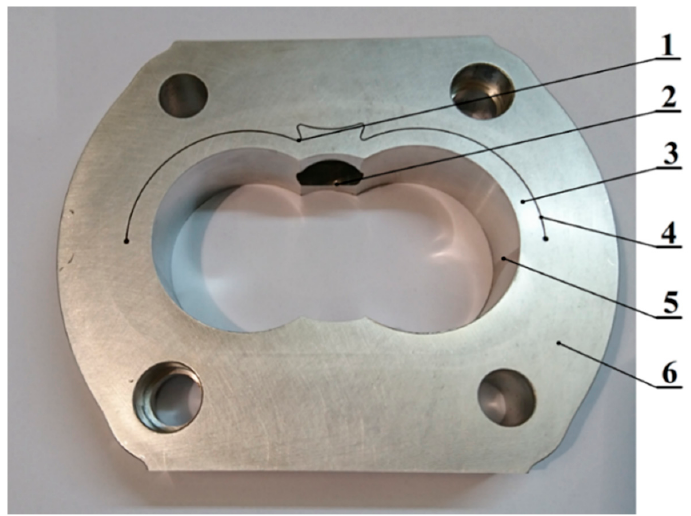
Figure 5. Pump casing with integrated circumferential backlash compensation with variable lip thickness, acc. to patent PL223649 (patent application P.404801 [22]), and with displacement